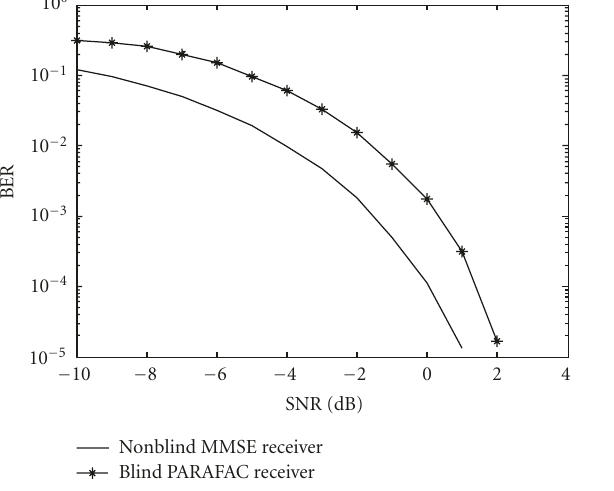
Figure 5: The algorithm performances comparison with N =